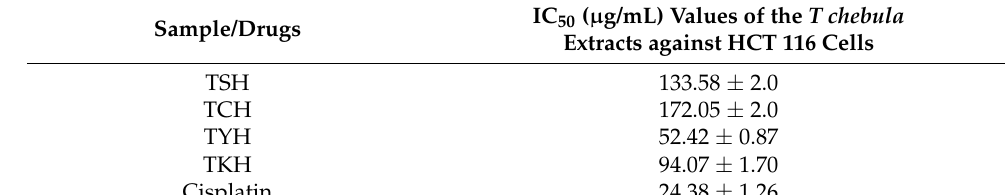
Table 4. IC 50 values of T. chebula extracts in HCT 116 cells.